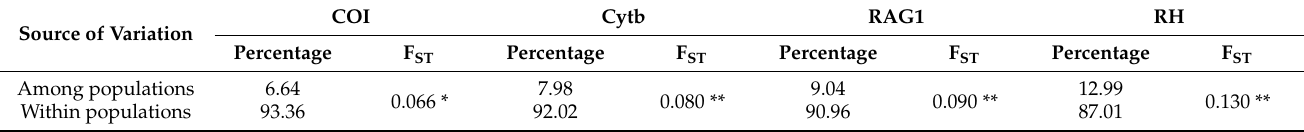
Table 3. Analysis of molecular variance for Jinshaia sinensis populations based on each gene. *: p < 0.05; **: p <